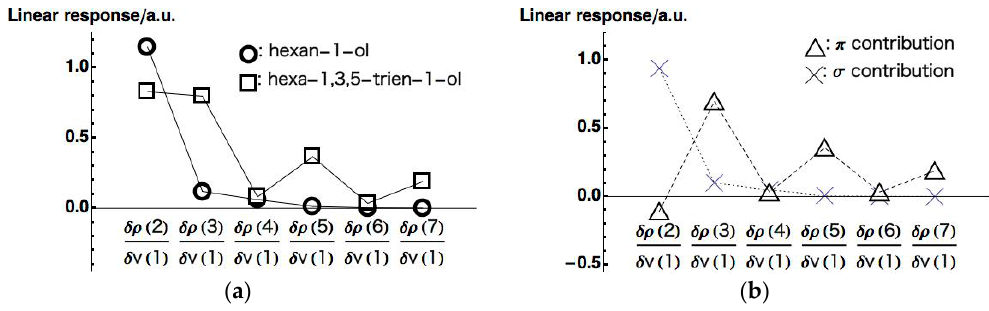
Figure 6. ( a ) Linear response function of density (LRF-Ds) of hexan-1-ol and hexa-1,3,5-trien-1-ol molecules; ( b ) σ and π contributions of LRF-D of the hexa-1,3,5-trien-1-ol molecules.